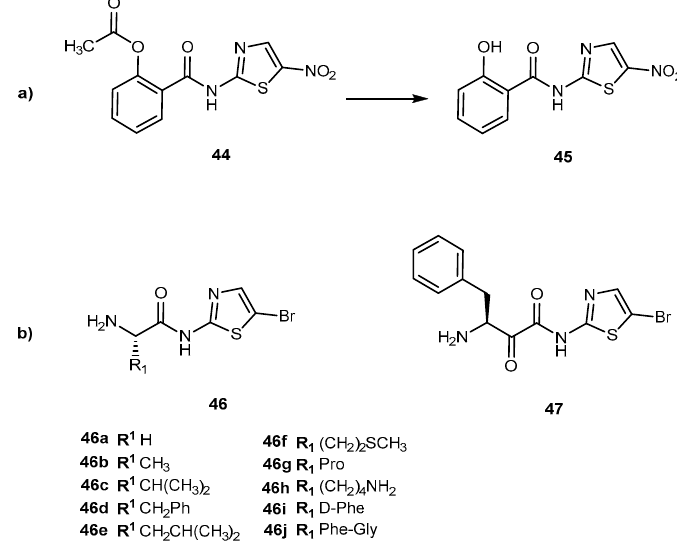
Figure 21. ( a ) Chemical structure of nitazoxanide ( 44 ) and its major active metabolite tizoxanide ( 45 ); ( b ) Bromothialozes derivatives with an amino acid moiety ( 46a – j ) and dipeptide.